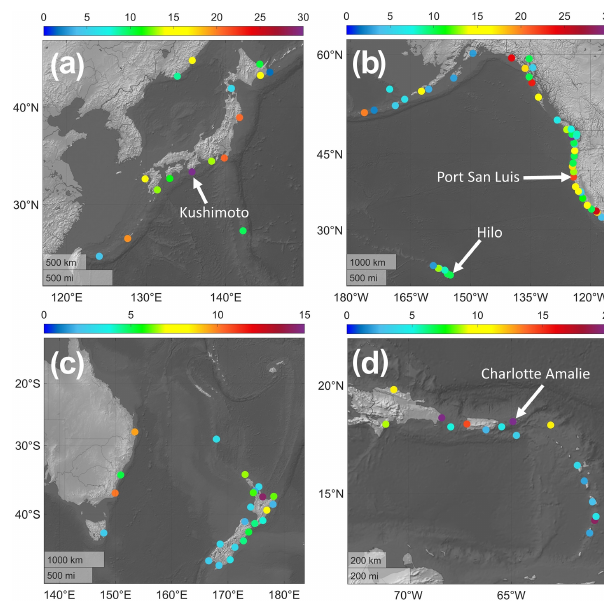
Figure 8. Amplification, β , in (a) Japan, (b) the northeastern Pa- cific, (c) New Zealand and Australia, and (d) the Caribbean. Loca- tions of note with large amplification which were discussed above are indicated: Kushimoto (Fig. 3), Hilo (Fig. 4), Port San Luis (Fig. 5), and Charlotte Amalie (Fig. 6). Note diverse color scales. Maps made in MATLAB using data from Natural